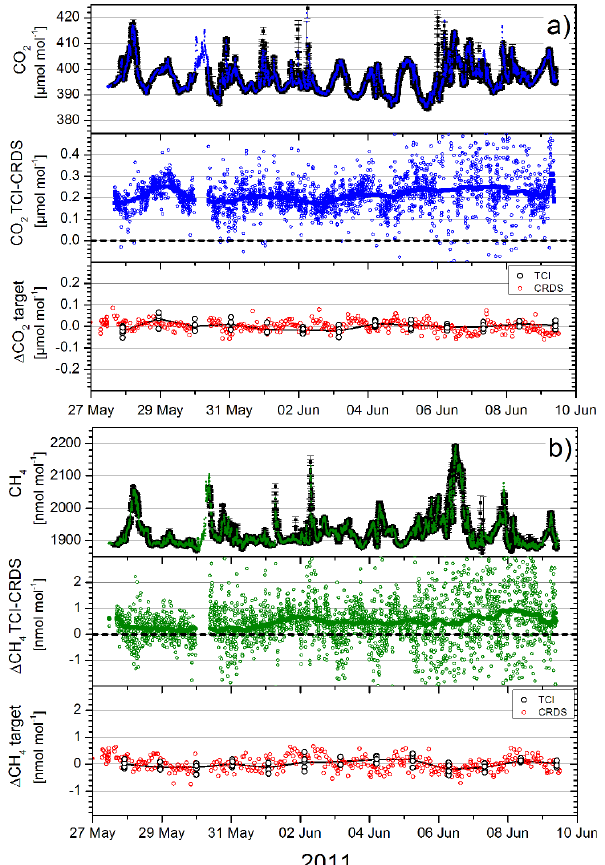
Fig. 4. Upper panels in (a) and (b) : comparison of CRDS (black) and TCI (blue/green) of CO 2 or CH 4 measurements performed at the 120m level at OPE. Middle panels: individual 3min mean CO 2 or CH 4 differences between the TCI and the smoothed CRDS measurements (open symbols); averaged differences (4h running median filter) as filled symbols. Note, the first 2days had to be excluded due to known problems of the CRDS intake system. Lower panels: individual 1min CRDS CO 2 or CH 4 target measurements in red and individual 3min TCI target measurements in black. For both instruments the target/surveillance gas deviations are given in a way to allow for direct trend comparison to the ambient air